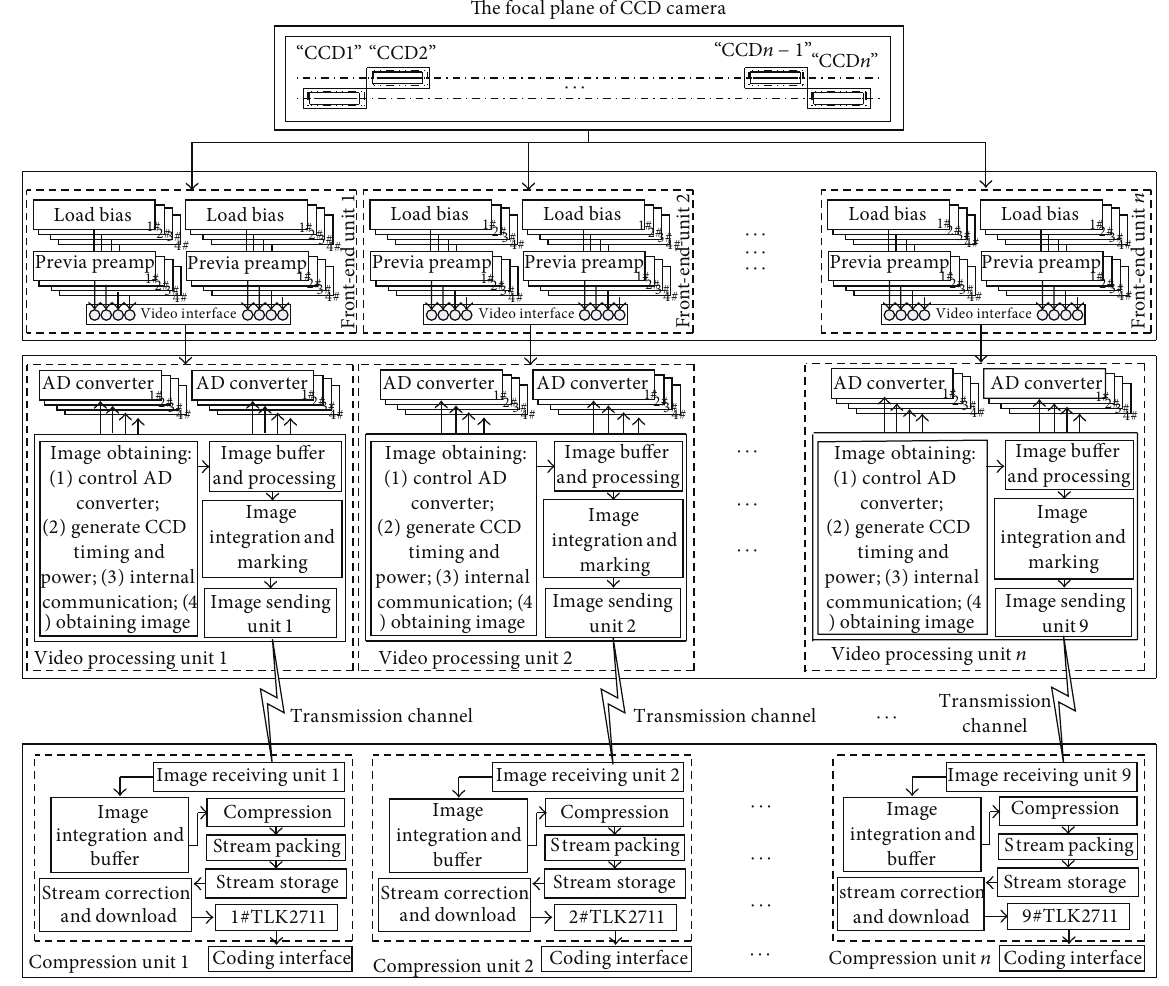
Figure 2: CCD image compression system.